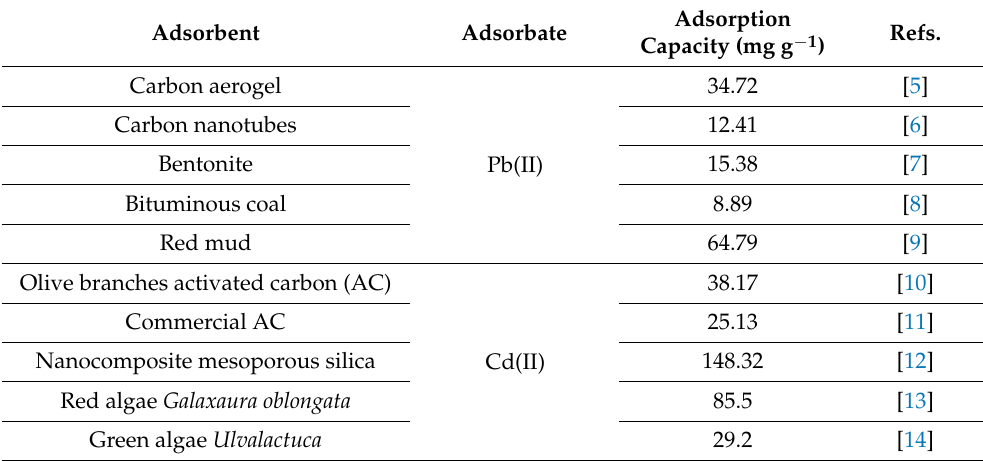
Table 1. Adsorption capacities for Pb(II) and Cd(II) from different conventional and novel adsorbents. Adsorbent Adsorbate